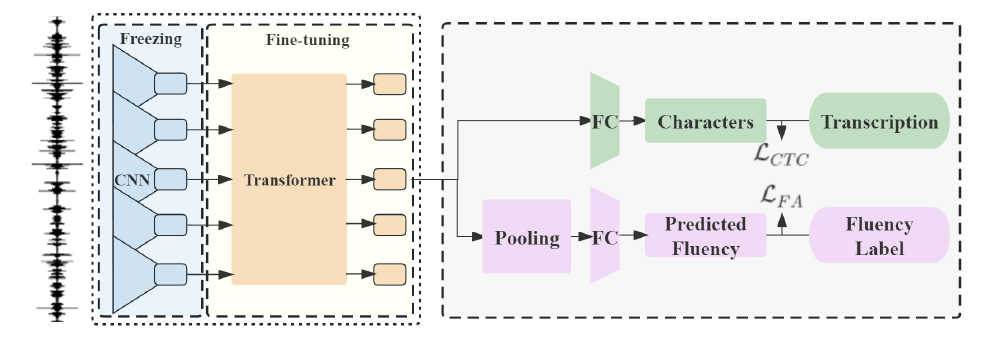
Figure 2. The proposed fine-tuning Wav2Vec2.0